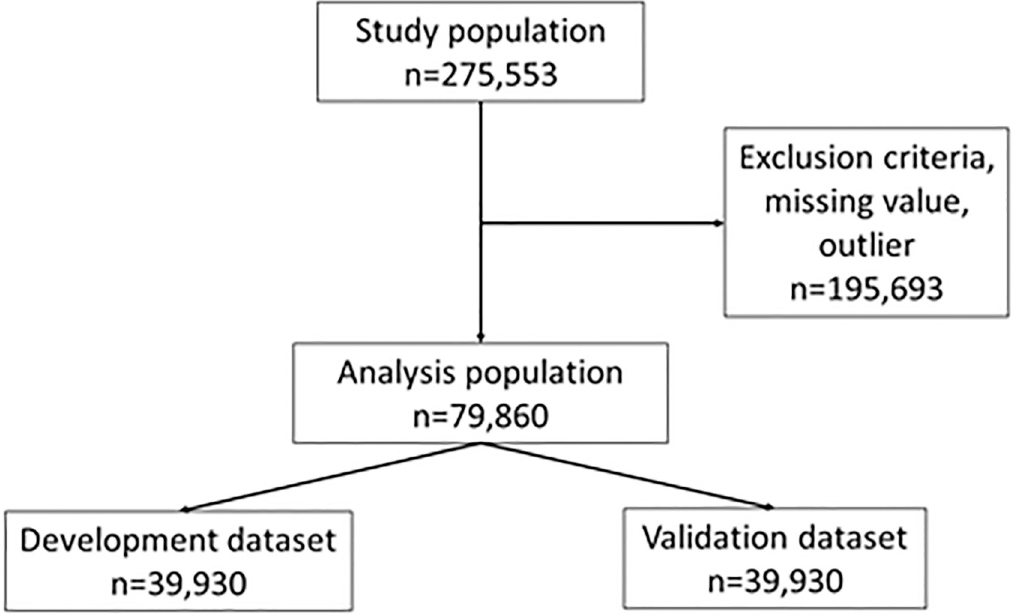
Fig 1. Randomization of study population and